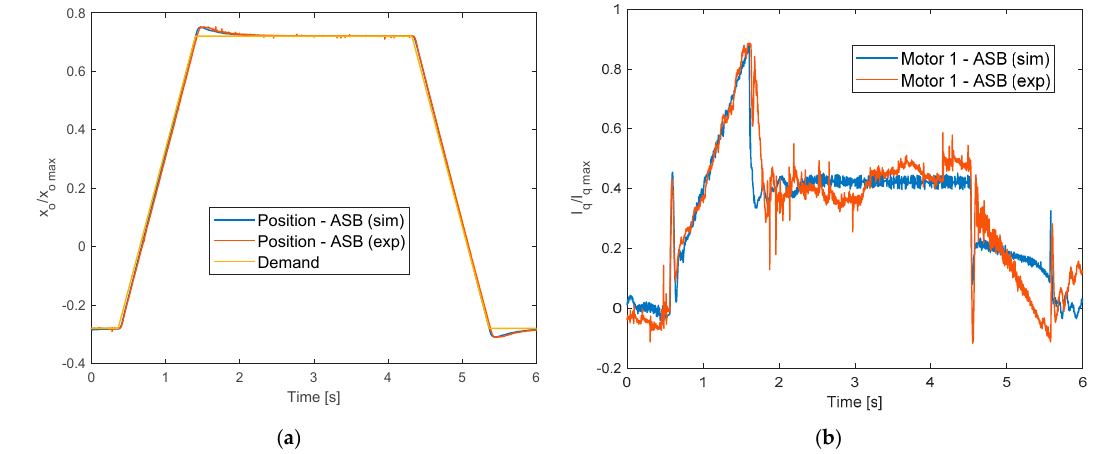
Figure 6. Time-domain model validation: position tracking in SBA mode with 100 kN/m spring-type loading (in Equation (24), k e = 10 5 N/m); ( a ) output position; ( b ) motors quadrature currents ( x o max = 25 × 10 − 3 m ; I q max = 25 A).